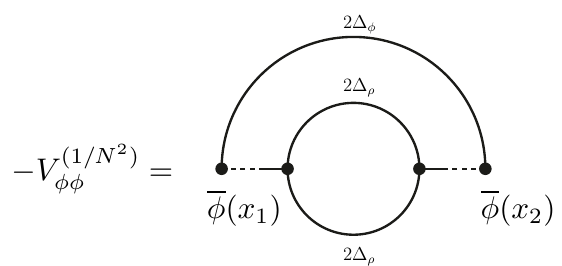
Figure 3 . The (1 /N 2 ) correction to the quadratic effective action of φ , where ¯ φ ( x ) is a given O background